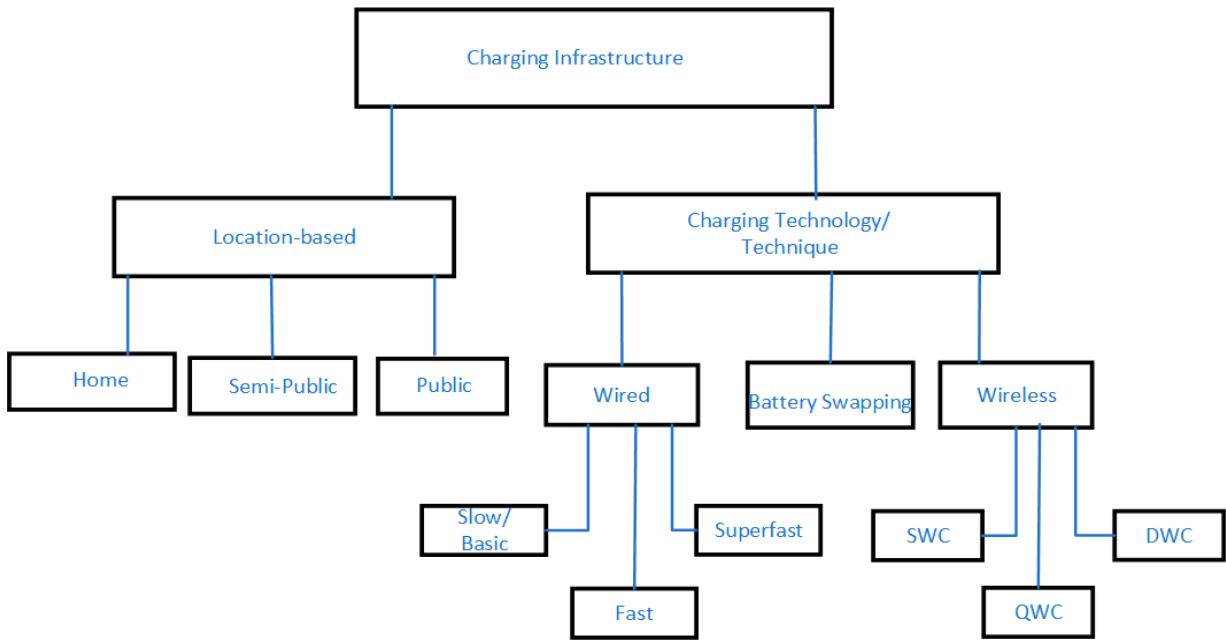
Figure 4. Classification of EV charging infrastructure.